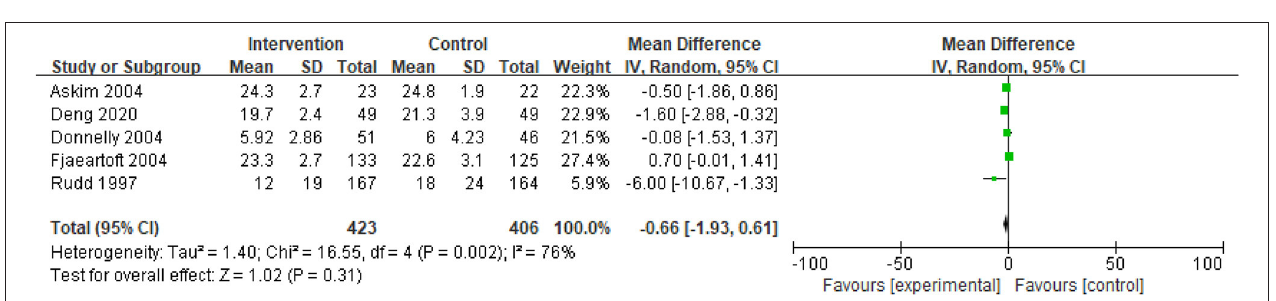
among studies (SMD = − 0.66; 95% CI, − 1.93 to 0.61; p = 0.31) ( Figure 6